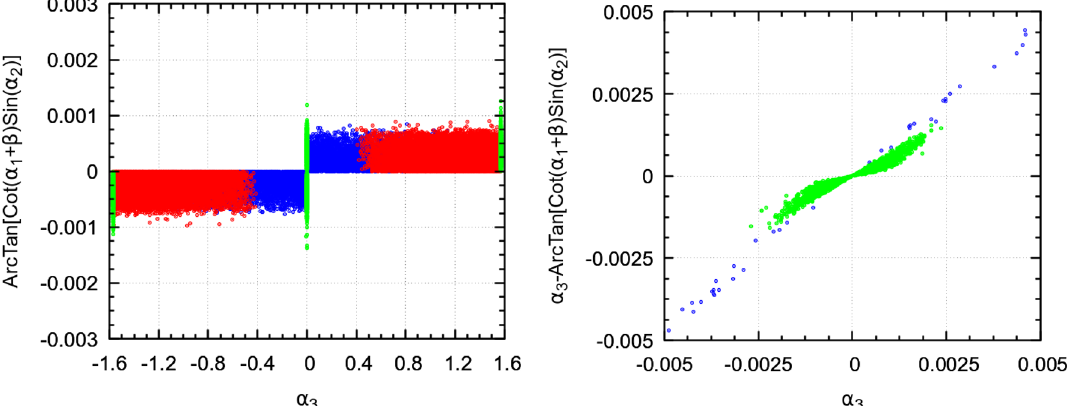
(cid:2) (cid:3) Figure 2. Left panel: arctan cot( α 1 + β ) sin( α 2 ) against α 3 , for the whole range of α 3 . Right (cid:2) (cid:3) panel: the difference between α 3 and arctan cot( α 1 + β ) sin( α 2 ) against α 3 , for a very restricted range of α 3 . In red, points leading to a non-negligible decay width for h 3 → ZZ ; in blue, points leading to a non-negligible decay width for h 3 → h 1 Z ; in green, points allowing the decay h 3 → h 2 Z